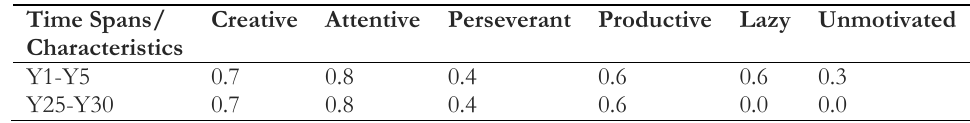
Table 6. The change in the mean values of fuzzy membership degrees for candidate 5 during the first and last time